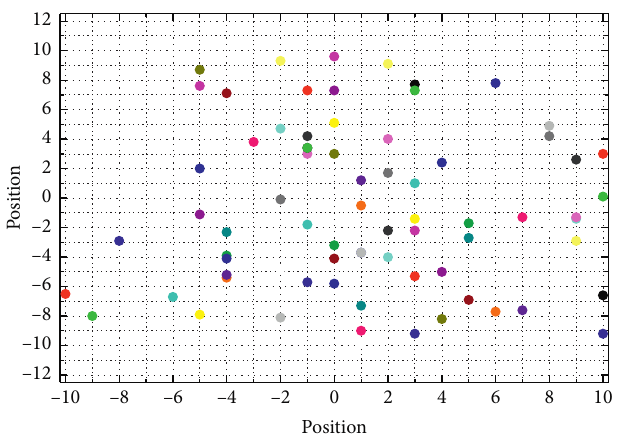
Figure 3: Particle swarm annealing algorithm to jump out of local optimum.